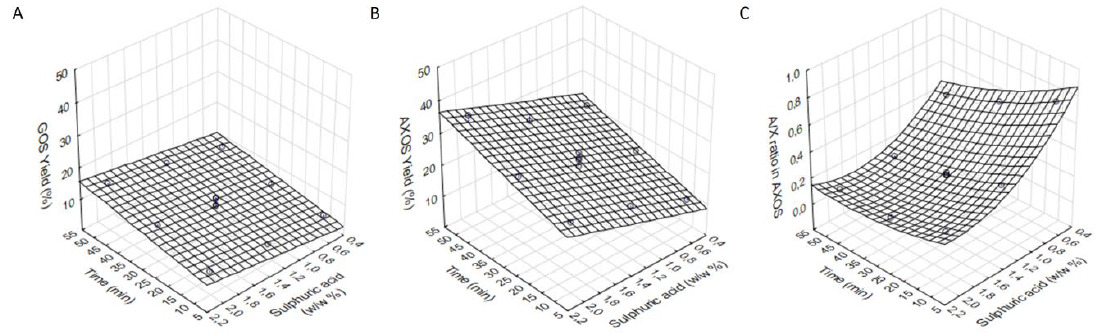
Figure 2. Fitted surfaces of the GOS yield ( A ), AXOS yield ( B ), and the A/X ratio in AXOS ( C ).